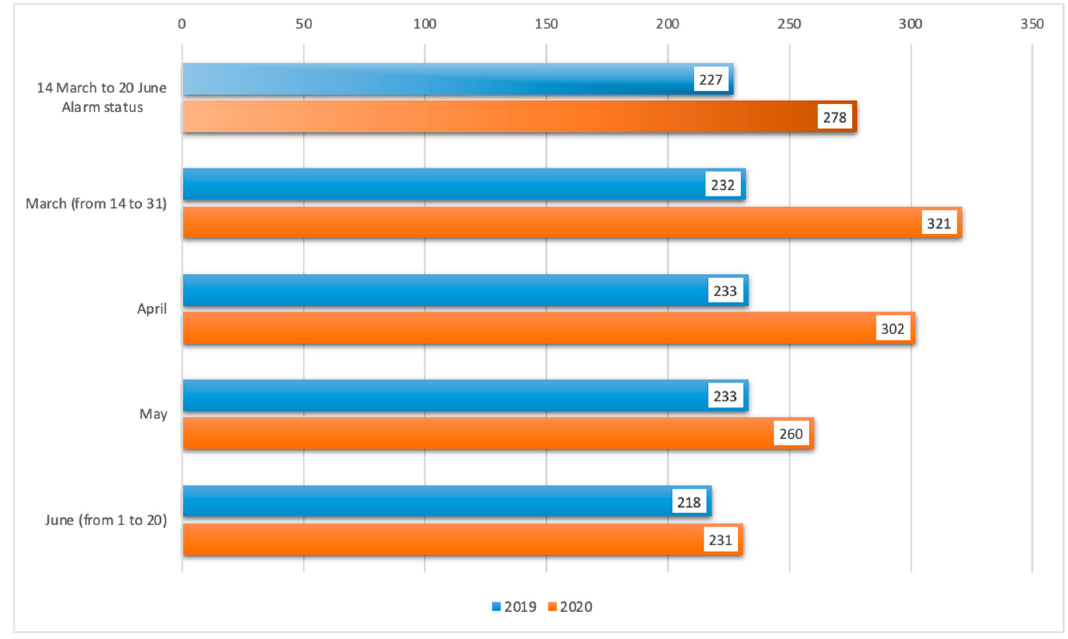
Figure 3. TV consumption in Spain during the alarm state (minutes of person/day) [50].